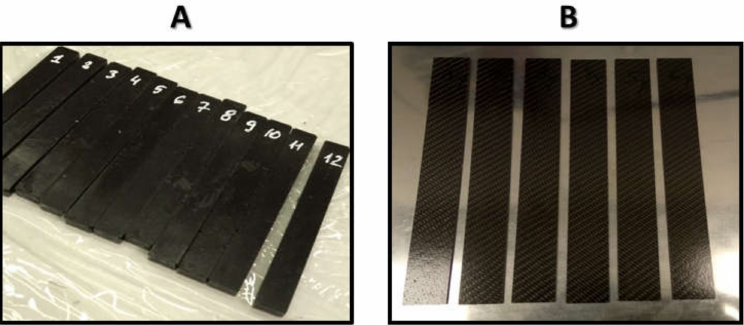
Figure 2. Overview photo of the example samples: ( A ) the vinylester resin / powder and ( B ) epoxy resin / basalt